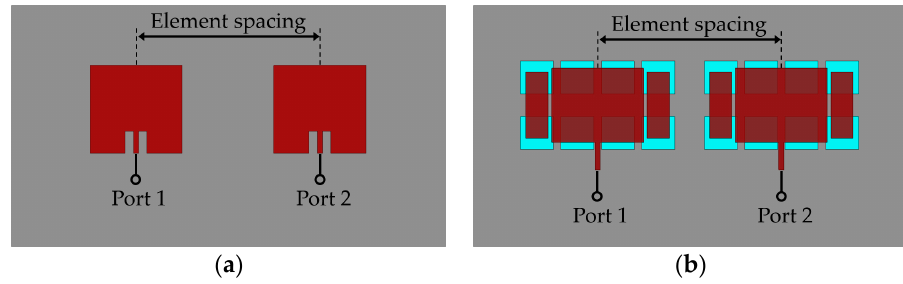
Figure 3. Simulation of 1 × 2 antenna array using ( a ) reference antenna element (Figure 1b) and ( b ) using proposed antenna with DGS (Figure 2).